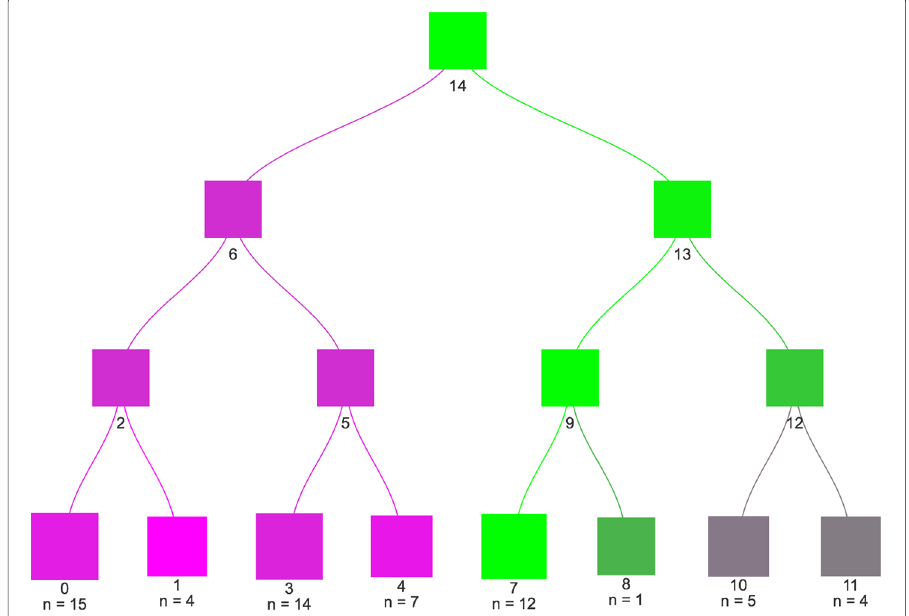
Fig. 5 Neural N-Tree rendered in real-time by the